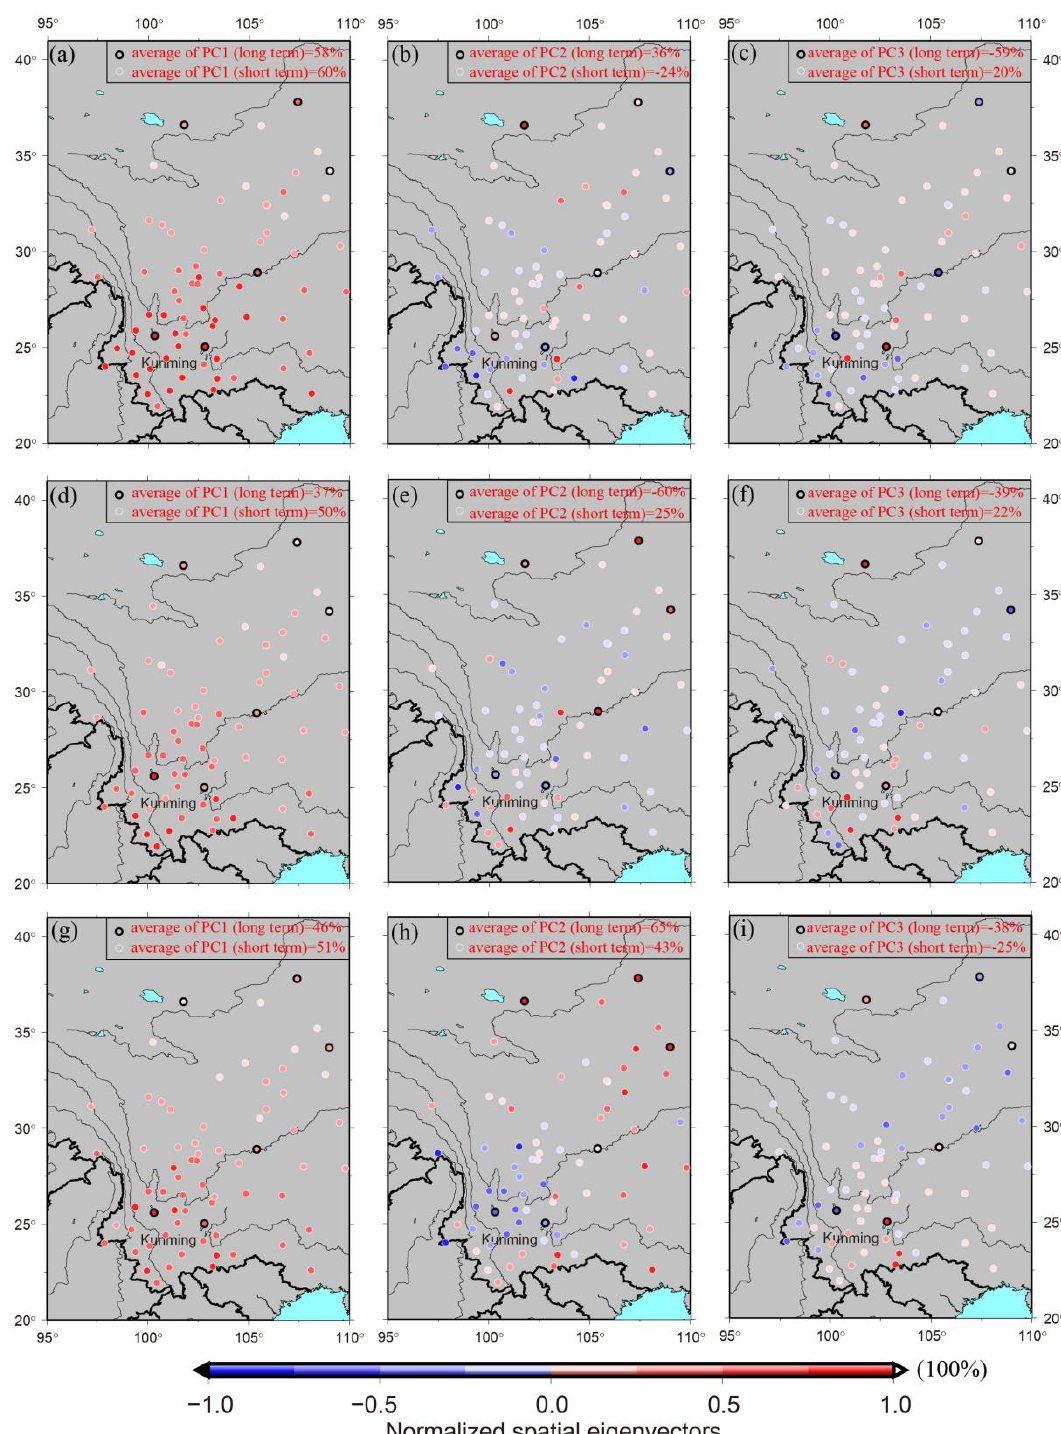
Figure 3. Spatial patterns of the scaled principle components (PCs) in the ETP. Red symbols represent positive responses to the scaled PC, whereas blue symbols represent negative responses to the scaled PC. The symbols with black circles denote 6 long-term GPS sites, while those with white circles denote 63 short-term GPS sites. ( a–c ) are the normalized spatial eigenvectors from PC1 to PC3 on the North component; ( d–f ) are the normalized spatial eigenvectors from PC1 to PC3 on the East component; and ( g–i ) are the normalized spatial eigenvectors from PC1 to PC3 on the vertical component. The scaled dots with lengths ranging from − 1 to 1 indicate a normalized range from − 100% to 100%.